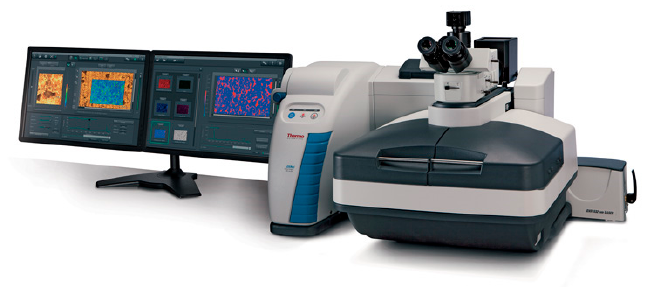
Figure 1. Thermo Scientific DXRxi Raman imaging microscope.